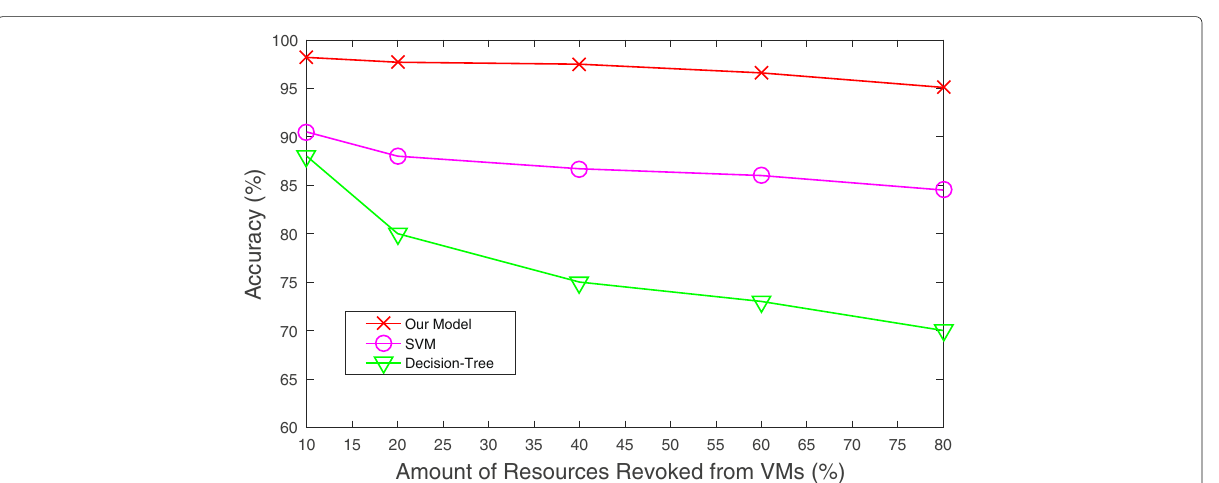
Fig. 4 Accuracy with respect to (w.r.t.) amount of revoked